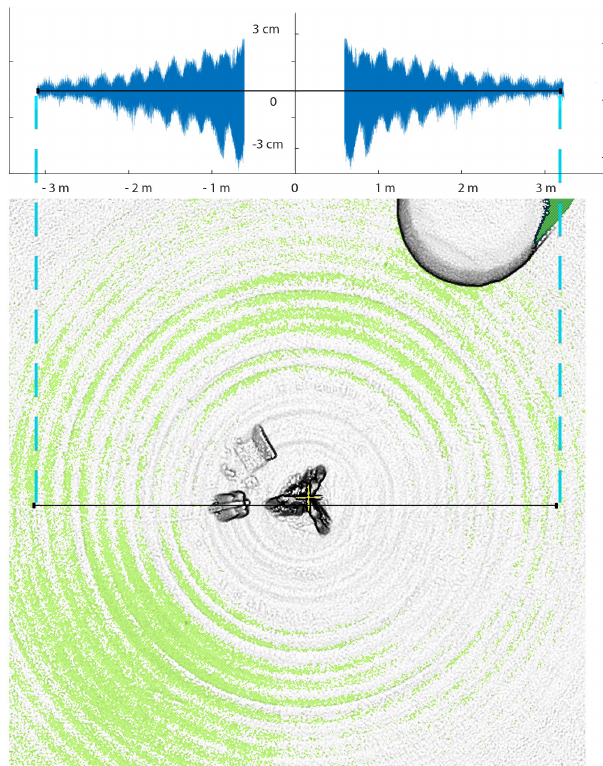
Figure 9. Artefact present near the TLS and its corresponding am- plitude.